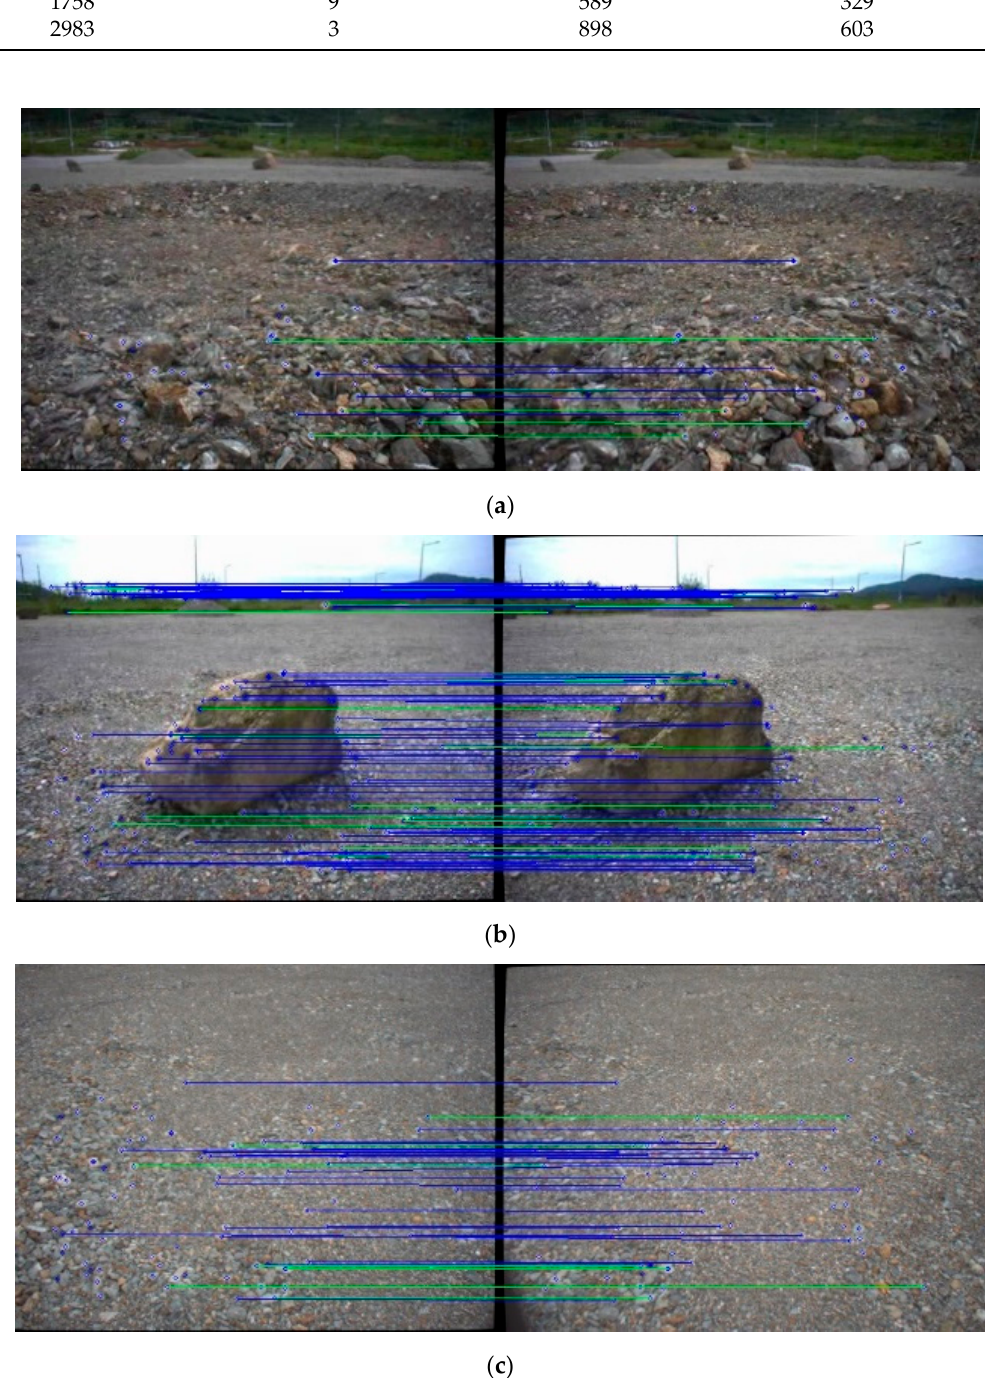
Figure 7. Feature-matching results from terrain features with AKAZE (threshold) (blue lines: feature match by disparity map and NNDR constraints, green lines: a feature match by disparity map but not NNDR constraint). ( a ) Crater with AKAZE (0.005); ( b ) rock with AKAZE (0.002); ( c ) ground with AKAZE (0.002). Table 1. Number of feature matches with different thresholds in AKAZE.